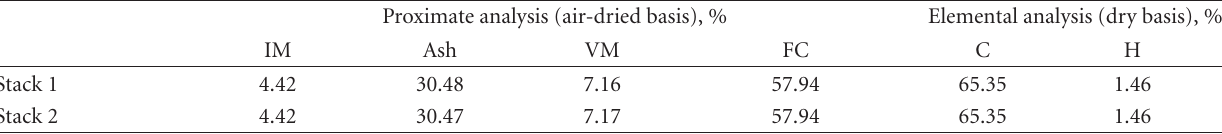
Table 6: Results of proximate and elemental analysis of anthracite sampled at the power plants.